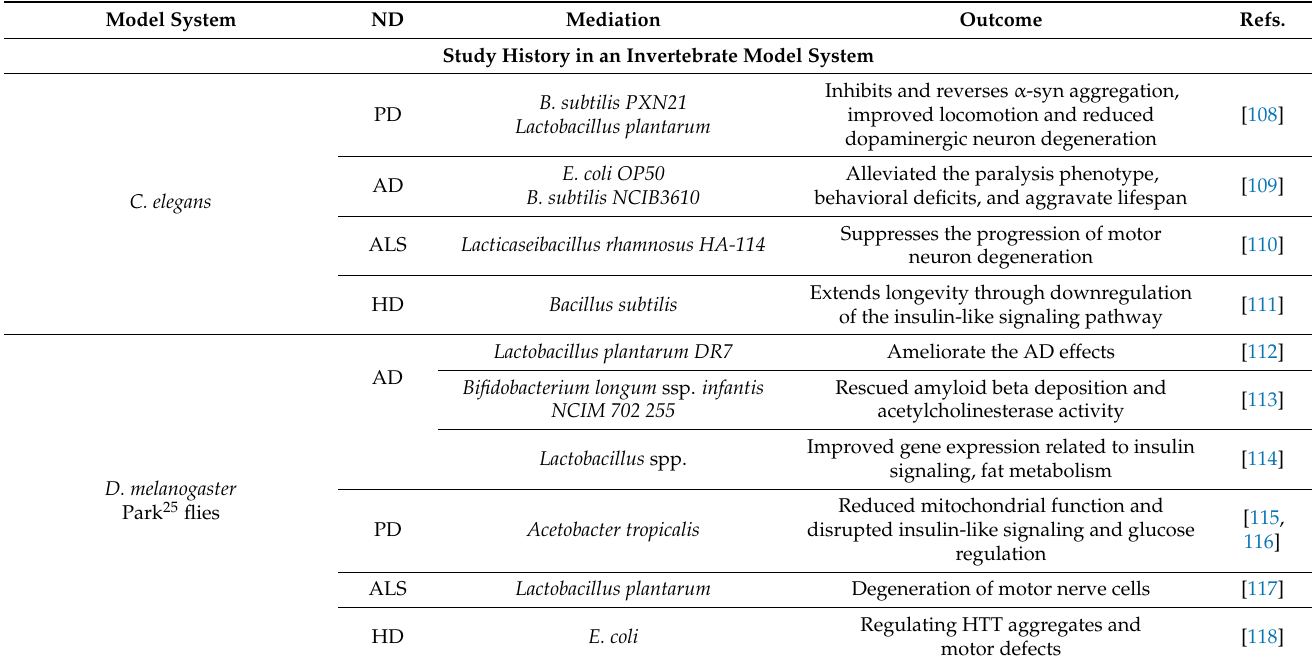
Table 3. Study of neurodegenerative diseases and their mediation with probiotics on different invertebrate and vertebrate model